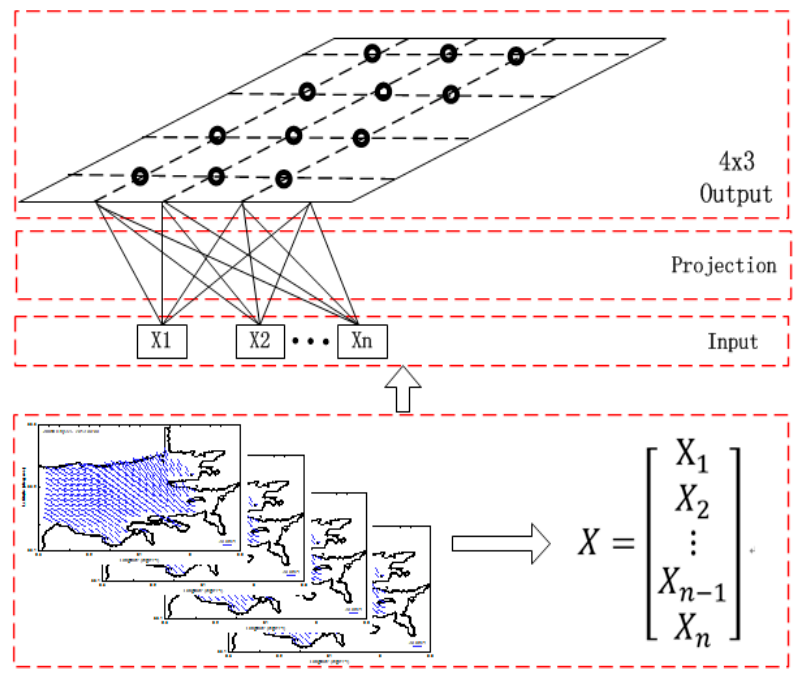
Figure 2. Architecture of a 4 × 3 self-organizing map (SOM) network.